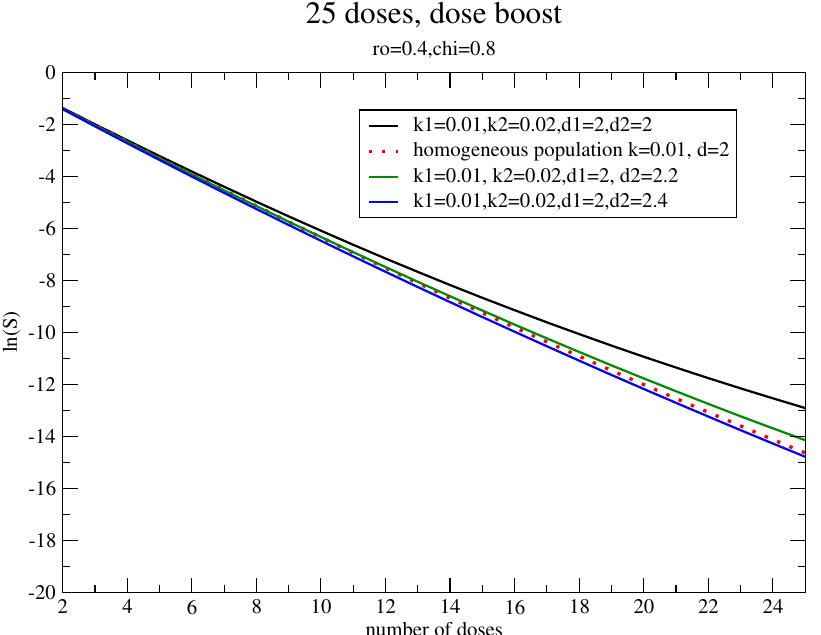
Figure 3. Estimate of the dose-boost with the same parameters of Figure